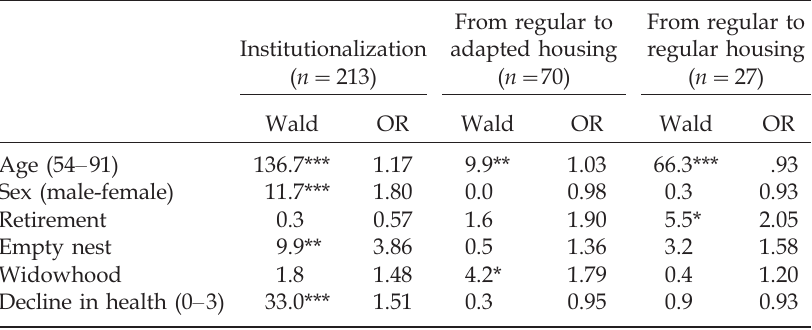
Table 2. Multinomial logistic regression analysis of types of mo v es on life e v ents in other life domains ( n (cid:2)